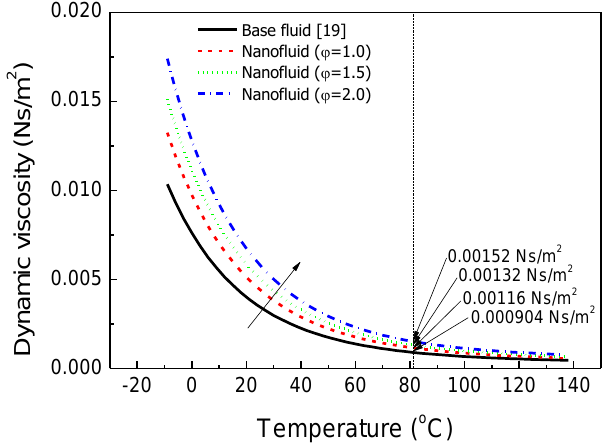
Figure 6. Dynamic viscosity modeling of the base fluid and Al 2 O 3 nanofluids.